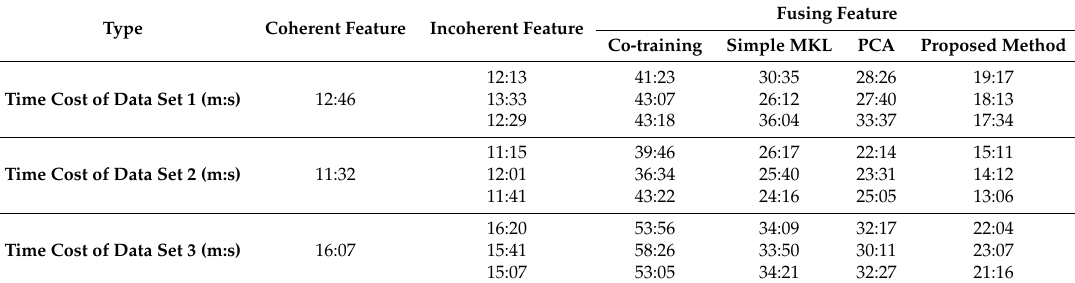
Table 2. Time costs of all the experiments of three data